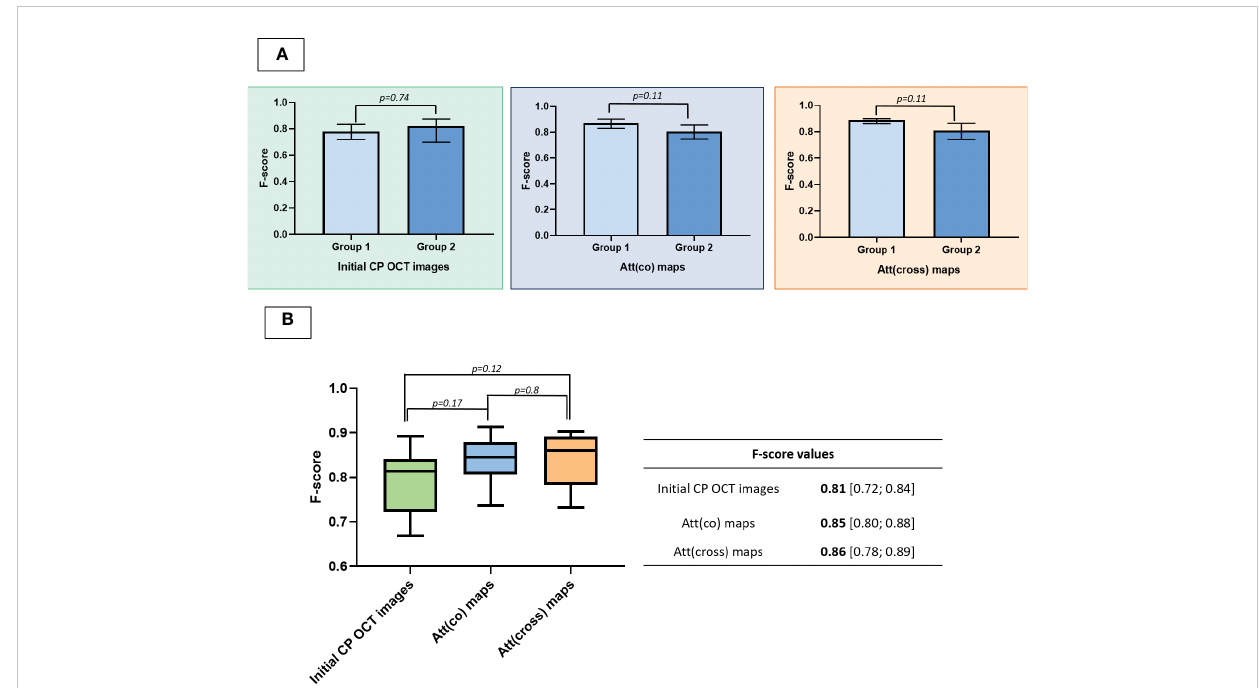
FIGURE 6 Diagnostic ability of different approaches to OCT data assessment for delineation of brain tissue types in the peritumoral area. A – F -score values of using different approaches to the evaluation of CP OCT images to differentiate normal white matter, damaged white matter and tumor. B – F -score values calculated in 2 subgroups of respondents where “ Group 1 ” includes researchers experienced in working with OCT data and “ Group 2 ” consists of researchers without previous experience in the analysis of OCT data. Data is presented as Me [Q1;